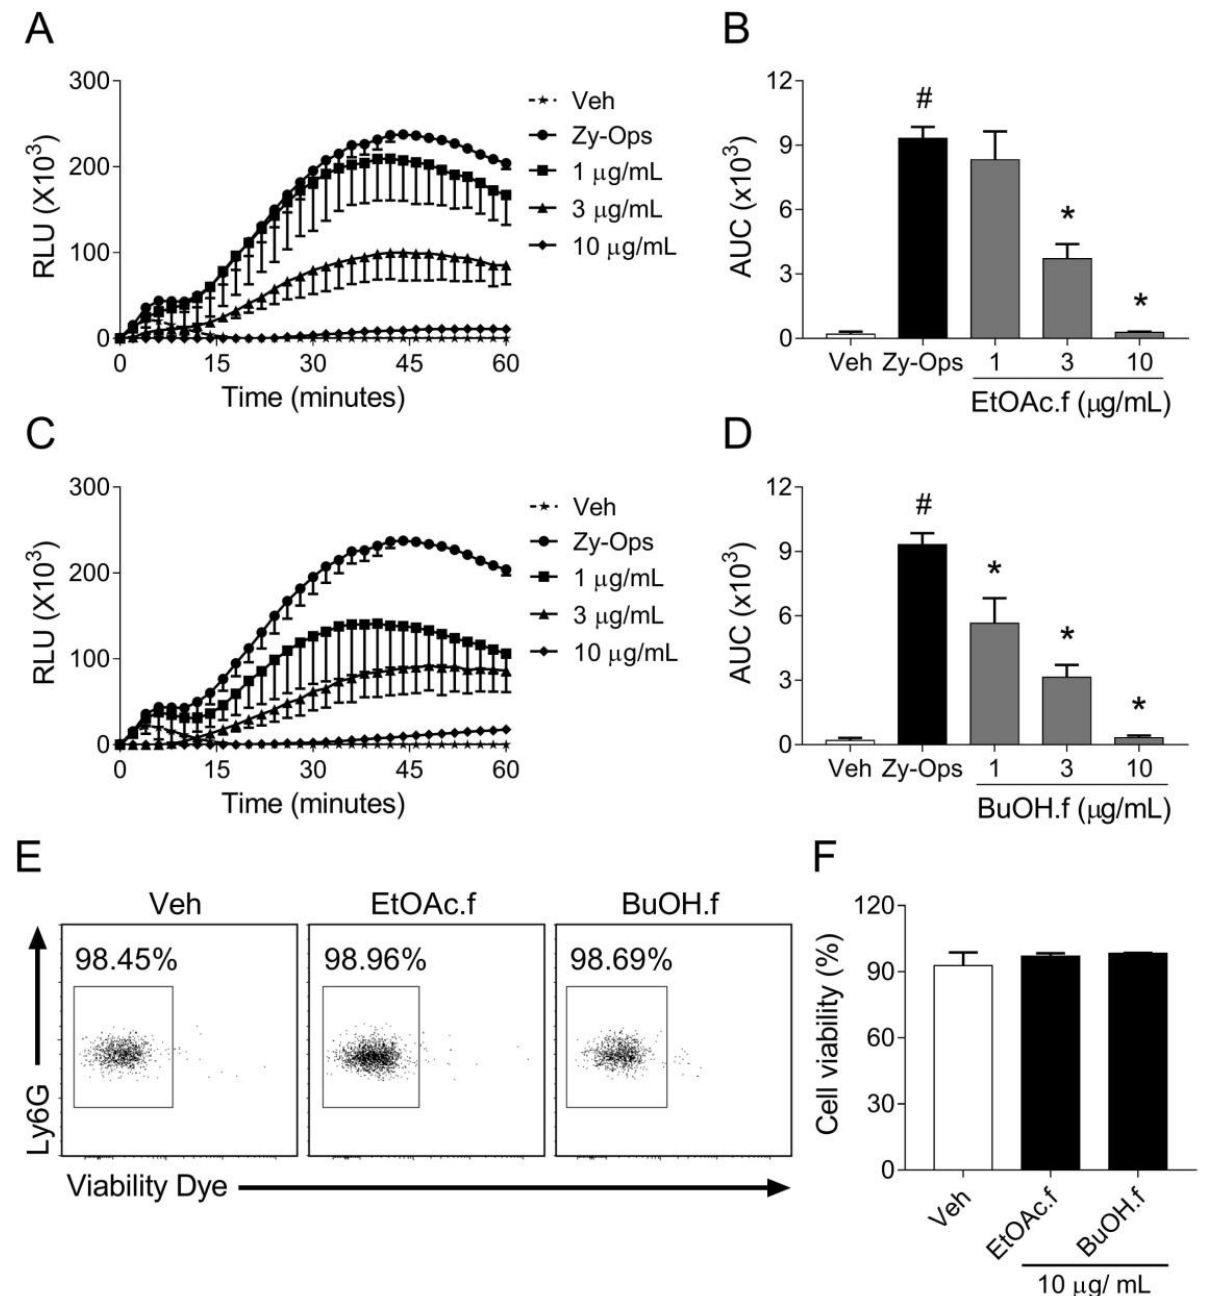
Figure 1. EtOAc.f and BuOH.f reduce ROS generation by neutrophils stimulated with opsonized zymosan. ( A – D ) Concentration-response curves of EtOAc.f ( A , B ) and BuOH.f ( C , D ) on the production of ROS by neutrophils in response to Zy-Ops (100 µg/mL); ( A , C ) are representative curves of ROS production over time; and ( B , D ) represent the area under the curve (AUC) as quantification of ROS. Each group was analyzed in triplicates. ( E , F ) Cell viability was determined through flow cytometry assay using Viability Dye; ( E ) representative dot blot resulting from cell acquisition in flow cytometer; ( F ) cell viability was calculated as the percentage of untreated cell group (Veh). Data represent mean ± S.E.M. of triplicates of one representative experiment. # and * indicate a statistically significant difference comparing to Veh group or Zy-Ops group, respectively, p < 0.05.